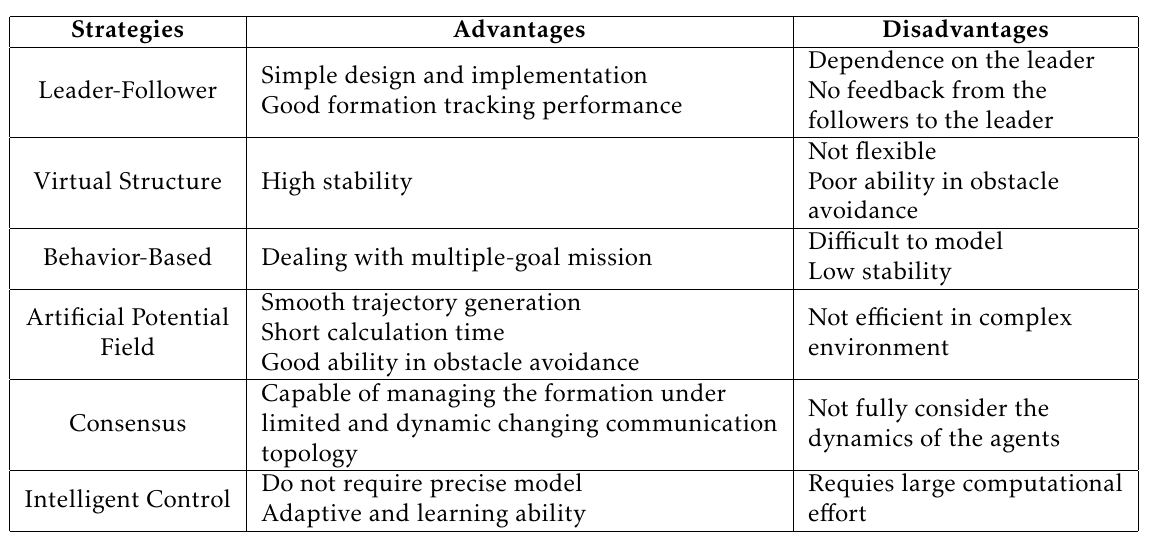
Table 1. Comparison of formation control